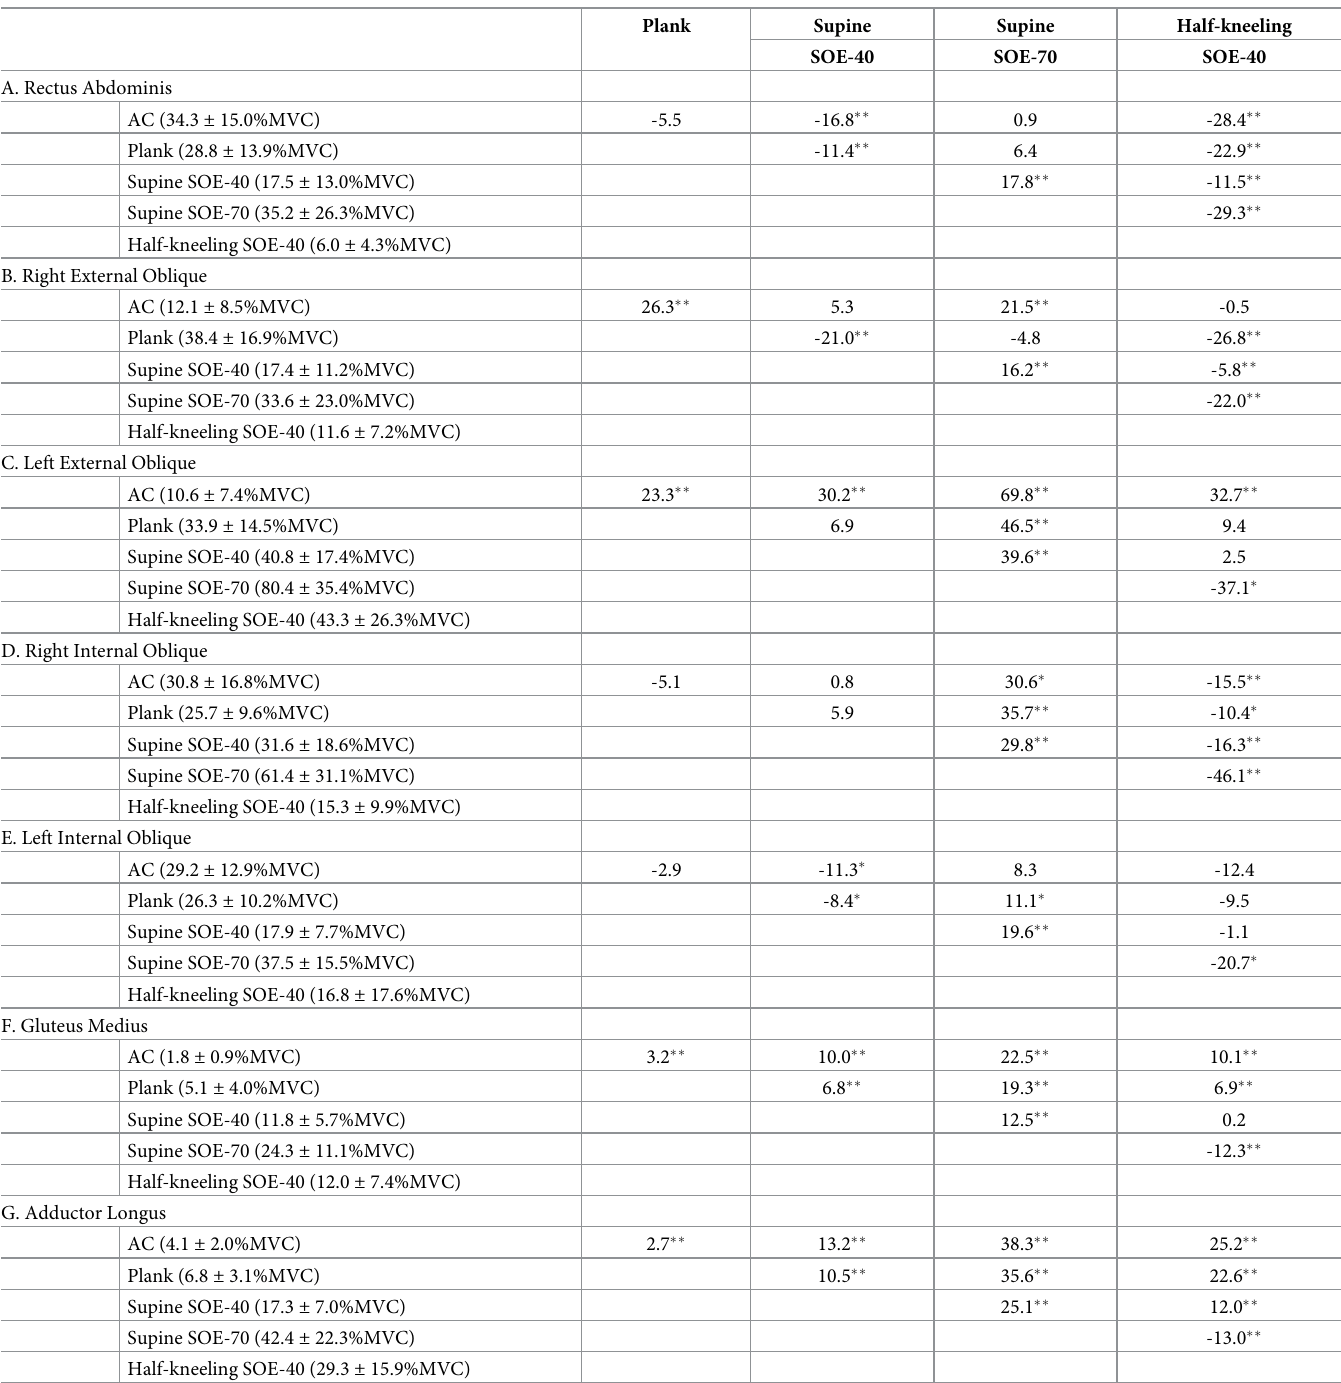
Table 1. Difference in %MVC muscle activity between exercise